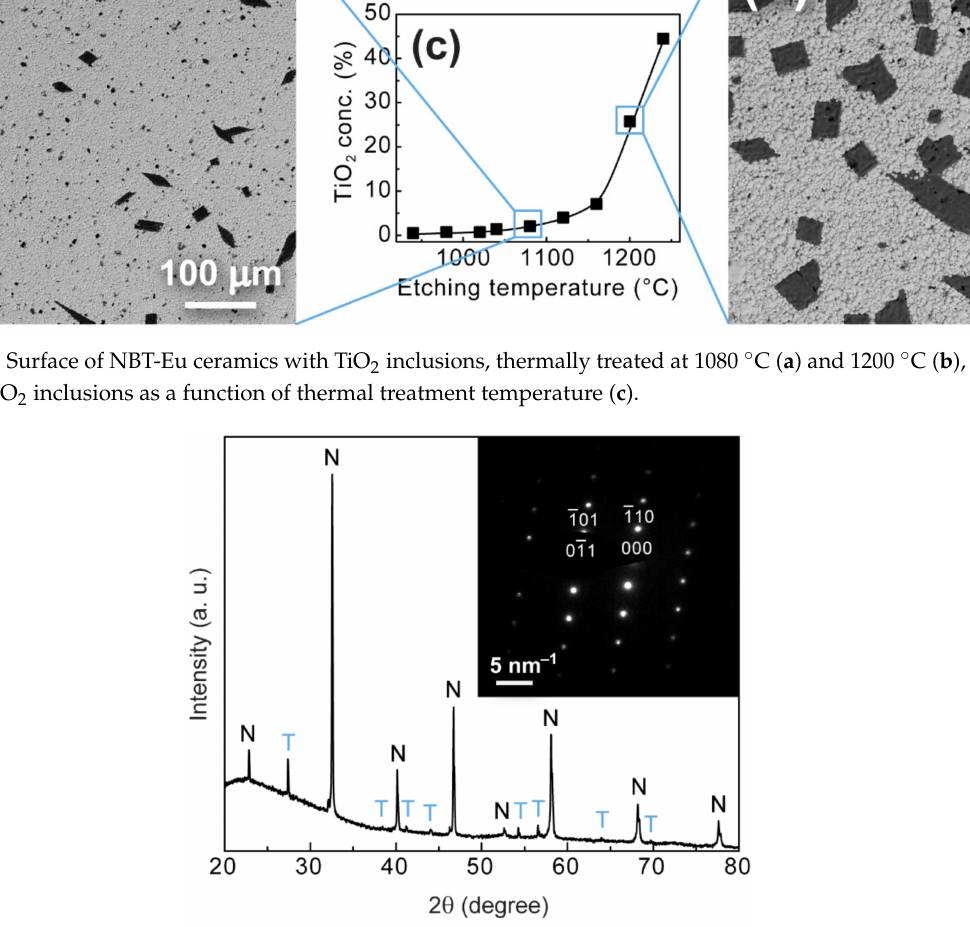
Figure 5. X-ray diffraction pattern of NBT-Eu thermally treated at 1200 ◦ C, where maxima from NBT-Eu (marked with N) and TiO 2 of rutile structure (marked with T) are observed. Inset is SAED, obtained from an NBT-Eu lamella containing a TiO 2 inclusion and cut from the non-treated sample (the diffraction maxima are indexed according to the rutile structure along the [111] zone axis). The increase in the inclusion concentration is obviously related to the evaporation of Bi and Na at high temperatures, and the decomposition of NBT-Eu. Increasing the size